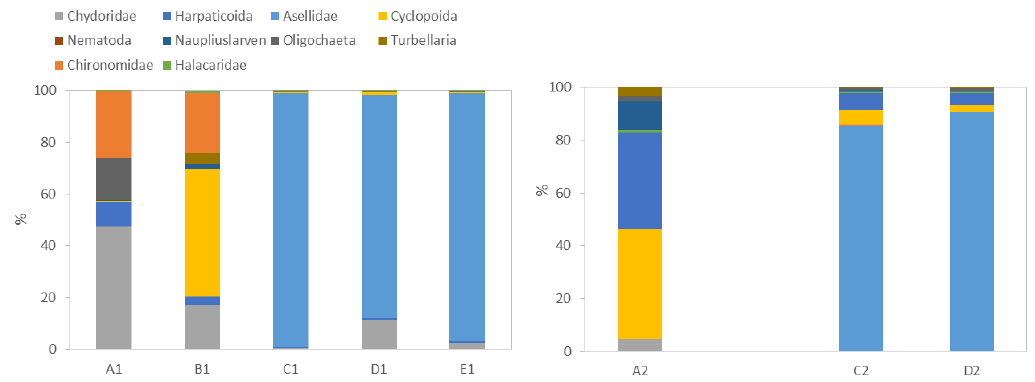
Figure 9. Change over distance in invertebrate composition (based on biomass concentrations) in the study system (left) and the reference system (right).